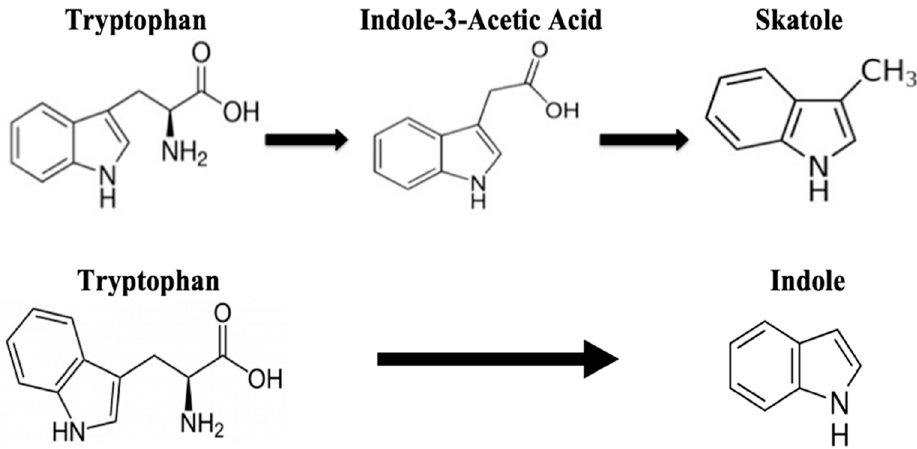
Figure 5. Microbial products of landfill gas sewery/fecal odors from amino acids. Based upon studies of anaerobically digested biosolids [13].